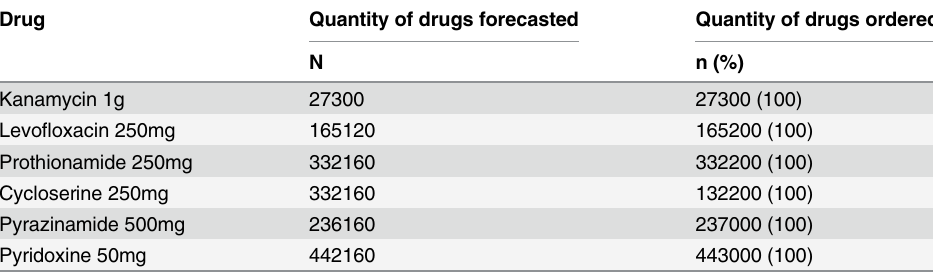
Table 2. Proportion of drugs for multidrug resistant tuberculosis ordered at the central level, out of the quantity forecasted for 2013, Nigeria (Target = 100%).